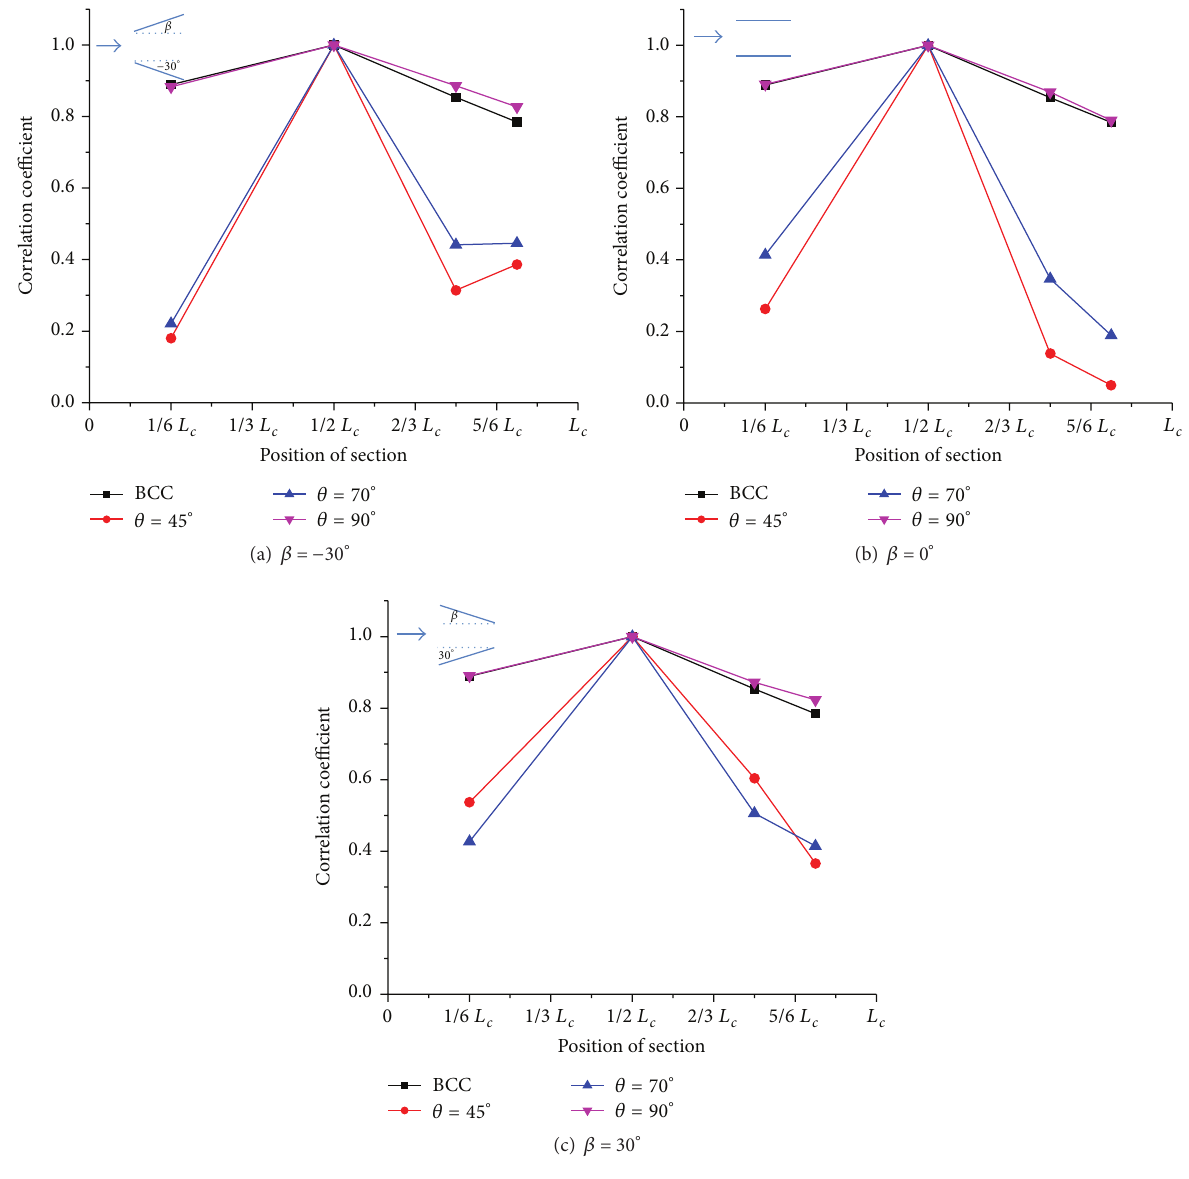
Figure 11: Correlation coefficients of lift ( 𝑈𝑟 = 7